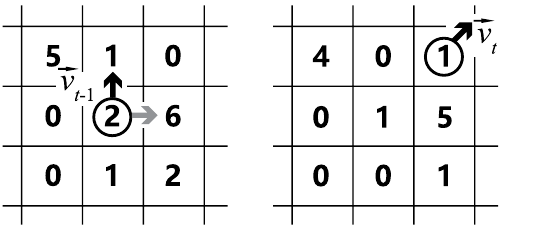
Fig. 4. Schematic diagram demonstrating the rules of the alarm pheromone model. The left and the right panels show the updating rules in the model from time step t { 1 to t , respectively. The circle denotes one ant, and the black arrows denote its current velocity vector. The numbers on the lattice denote the amount of pheromone, and the gray arrow pointing to 6 denotes the vector from the ant to the lattice where the concentration of pheromone is largest within its detection range. It should be noticed that the pheromone amount value in the simulation is not real world pheromone amount value. In our simulation, the amount of pheromone an ant puts on lattice and the amount of pheromone evaporates each time step are both less than 1. For simplicity, we use integers